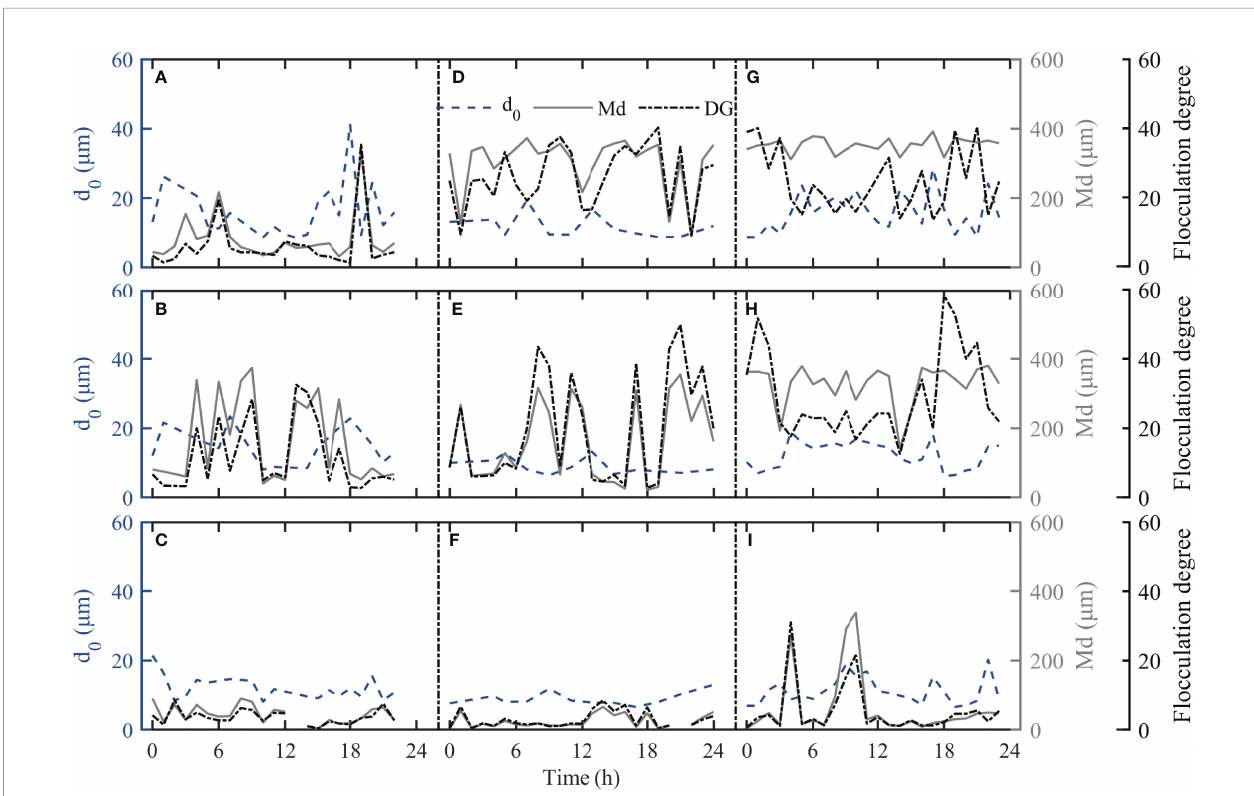
FIGURE 5 | Vertical and temporal variation of median dispersed particle size ( m m), median measured particle size ( m m), and fl occulation degree parameter ( A – C, D – F, G – I , represent the spring, middle, and neap tides, respectively, A, D, G represent the surface layer, B, E, H represent the middle layer, C, F, I represent the bottom layer, the blue dash lines are the median dispersed particle size, the gray lines are the median fl oc size, and the black lines are the fl occulation degree